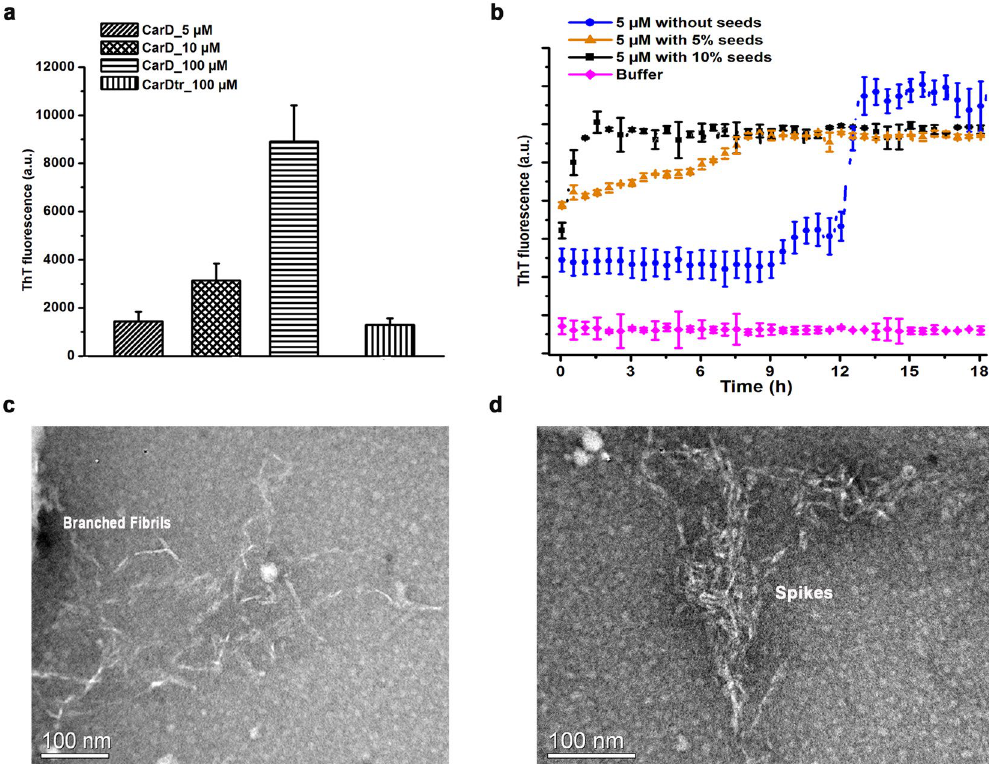
Figure 6. CarD forms amyloid-like fibrils in solution. ( a ) Thioflavin T fluorescence assay: Staining of native CarD (5, 10 and 100 μ M) and CarDtr (100 µ M) with amyloid specific fluorescent dye, Thioflavin T (ThT) at 37 °C after 15 min shows enhanced fluorescence intensity in case of native CarD as compared to CarDtr. The average fluorescence intensity and standard error bars have been calculated from three independent experiments. ( b ) The kinetics of amyloid-like fibril formation of native CarD (5 μ M) in the absence and presence of 5% and 10% seeds monitored at 37 °C. The ThT fluorescence intensity was measured using excitation wavelength of 440 nm and emission wavelength of 482 nm. ( c and d ) The transmission electron microscopy (TEM) was used to visualize the CarD amyloids. The electron micrographs reveal several branched amyloid-like fibrils ( c ) and spikes (the aggregates of amyloid-like fibrils; d